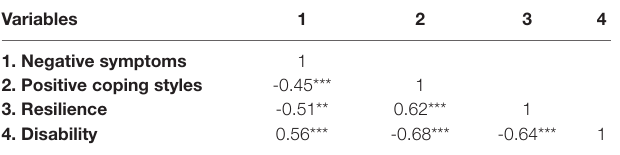
TABLE 2 | Correlation analysis of study variables. Variables